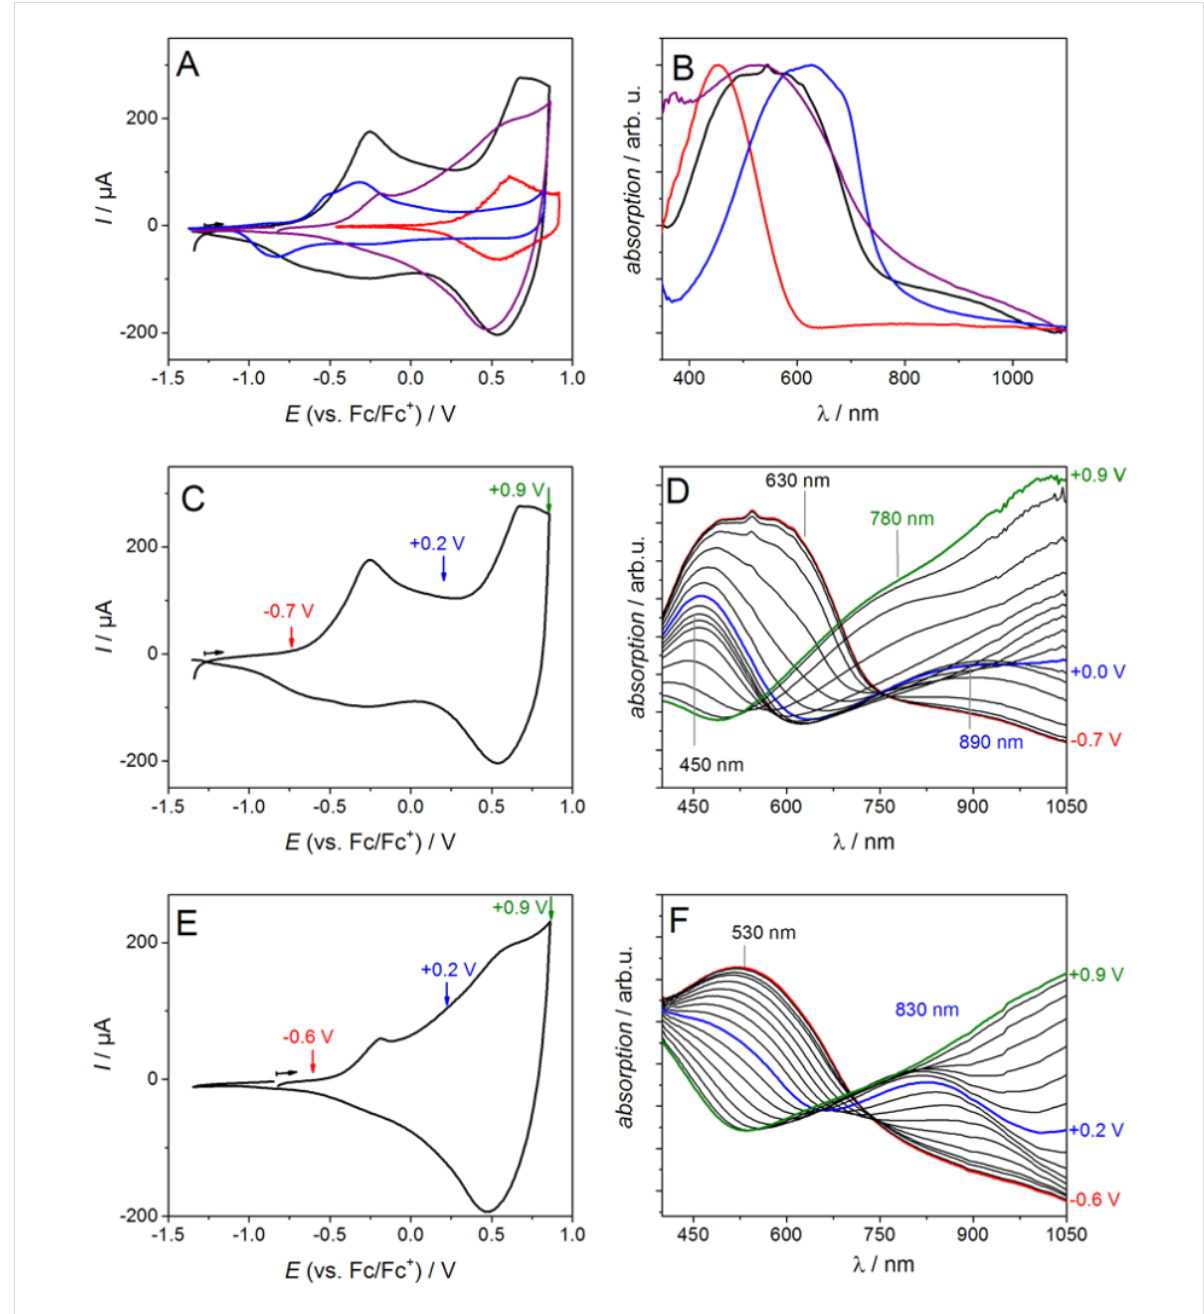
Figure 1: Cyclic voltammograms in 0.1 M NBu 4 PF 6 /MeCN (A) and vis–NIR spectra (B) of electropolymerized films of PEDOT (blue curve), P3T (red curve), PEDOT/P3T-blend (black curve) and P(EDOT- co -3T)-1:1 (purple curve) deposited on ITO-coated glass substrates. C–F: In situ spectroelec- trochemistry of films deposited under potentiostatic control on ITO with oxidative cycles at 50 mV s − 1 in 0.1 M NBu 4 PF 6 /MeCN (C and E) and vis–NIR spectra (D and F) recorded during the forward scan in the oxidation process of PEDOT/P3T-blend (C and D) and P(EDOT- co -3T)-1:1 (E and F). The films were prepared according to